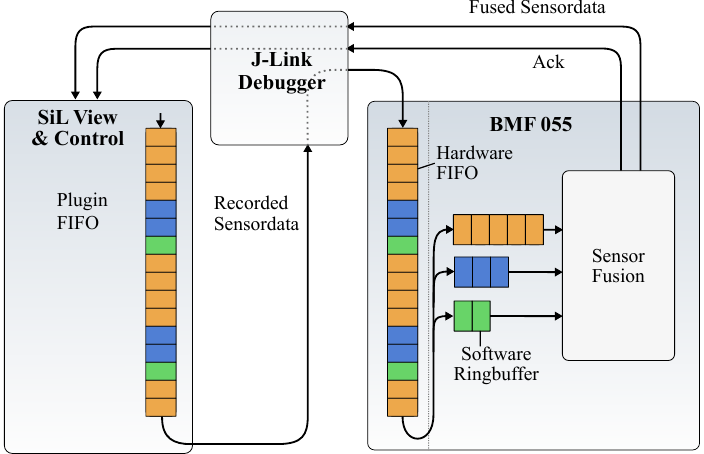
Figure 7. Buffer structure of the SIL